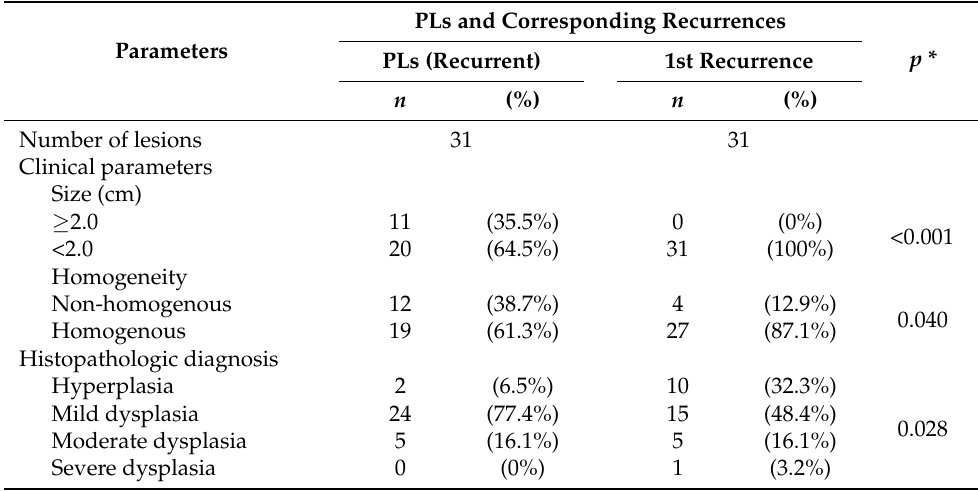
Table 6. Comparison of clinical (size and homogeneity) and histopathologic parameters between